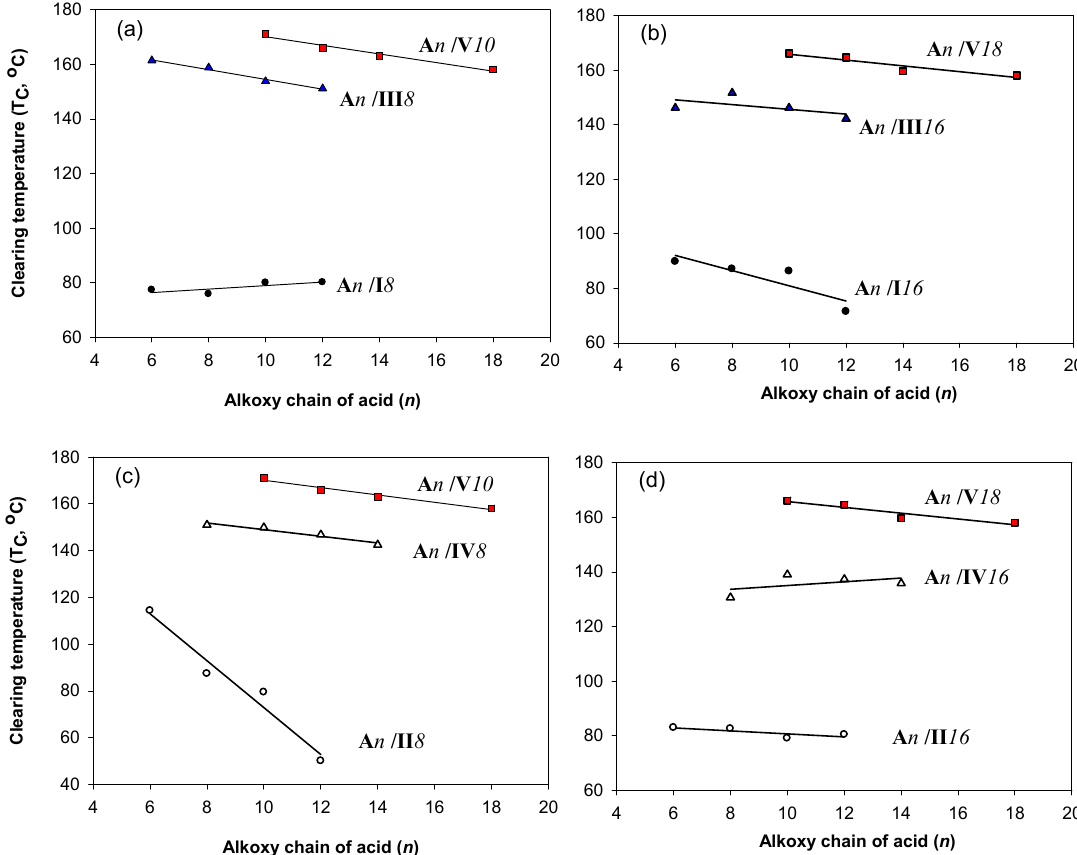
Figure 5. Mesophase stability temperature ( T C ) dependency on the terminal alkoxy chain length ( n ) of the acid complement; ( ● ); A n / II m ( ○ ); A n / III m ( ▲ ); A n / IV m ( ∆ ); A n / IV m ( ), ( a ) A n / I 8, A n / III 8, A n / V 10 ( b ) A n / I 16, A n / III 16, A n / V 18 ( c ) A n / II 8, A n / IV 8, A n / V 10, ( d ) A n / II 16, A n / IV 16, A n / V 18 .